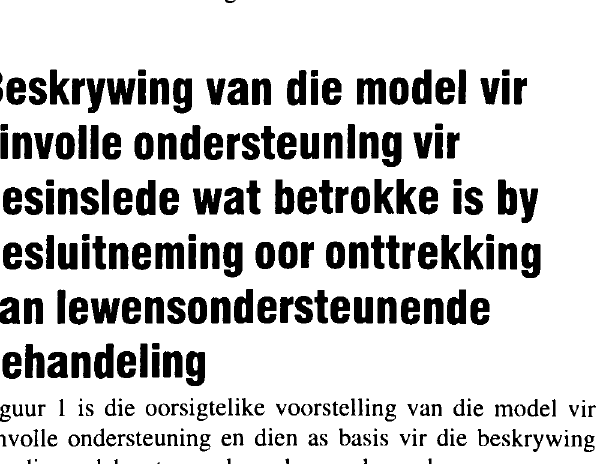
Figuur 1 is die oorsigtelike voorstelling van die model vir sinvoiie ondersteuning en dien as basis vir die beskrywing van die model wat vervolgens bespreek word.